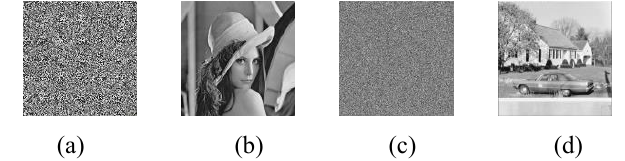
Fig. 2. Lena (a) Encrypted image. (b) Decrypted image. House. (c) Encrypted image. (d)